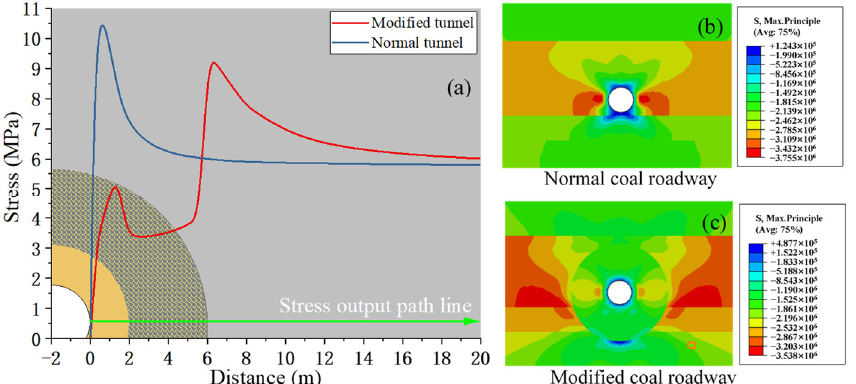
Figure 5. Maximum principal stress distribution ( a ) along a path line away from the tunnel roadway, ( b ) contour of stress around a normal coal roadway and ( c ) a modified roadway.